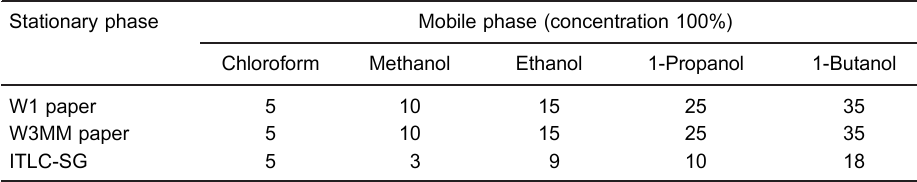
Table 1. Chromatography running time (in min) for [ 99m Tc(MIBI) 6 ] + related to the chromatographic system used. Stationary phase